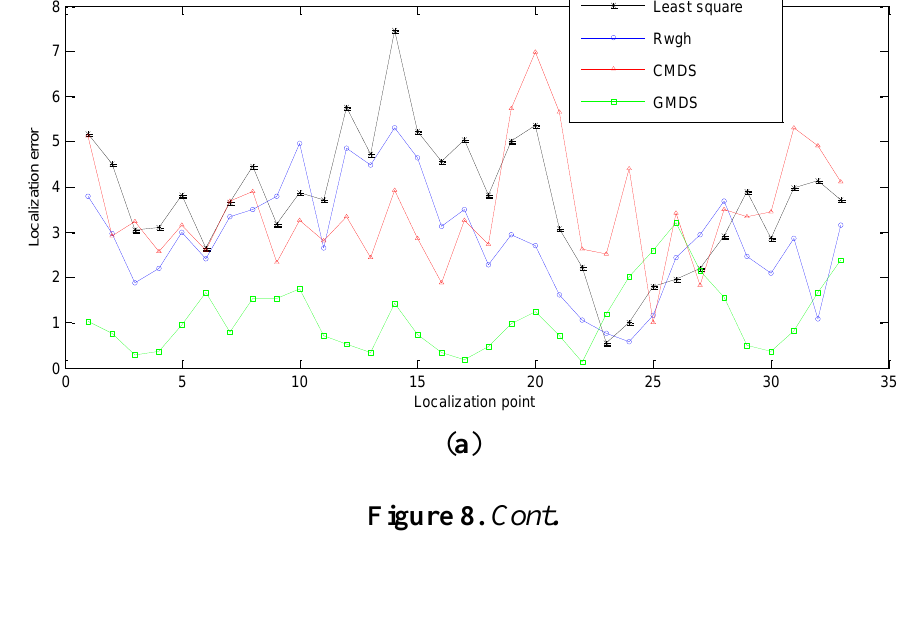
N  . ( a ) Localization error when nlos N nlos